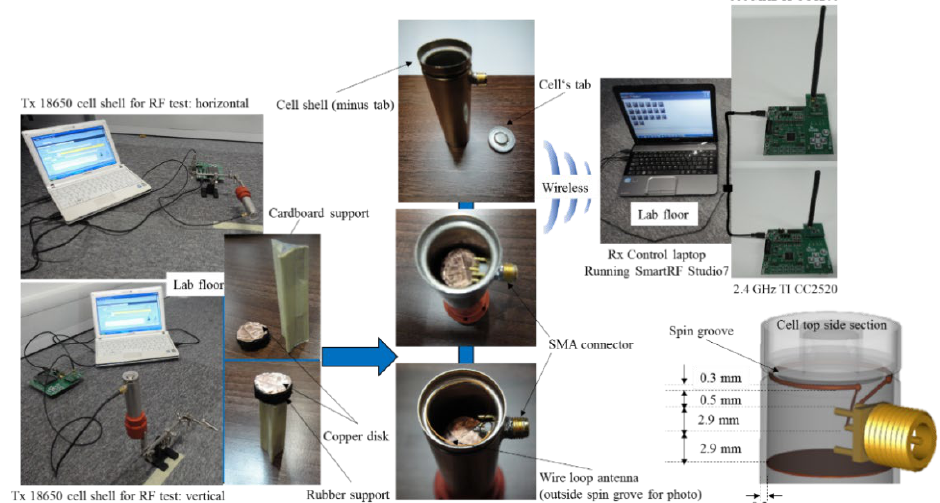
Figure 3. Experimental test systems used for 868 MHz and 2.4 GHz communication range testing inside the laboratory. The copper conductive surface/disk is fixed on a circular foam support which provides flexibility when inserted in the cell after previous SMA definitive positioning. Cardboard is used to raise the copper to the bottom of the SMA without touching it.